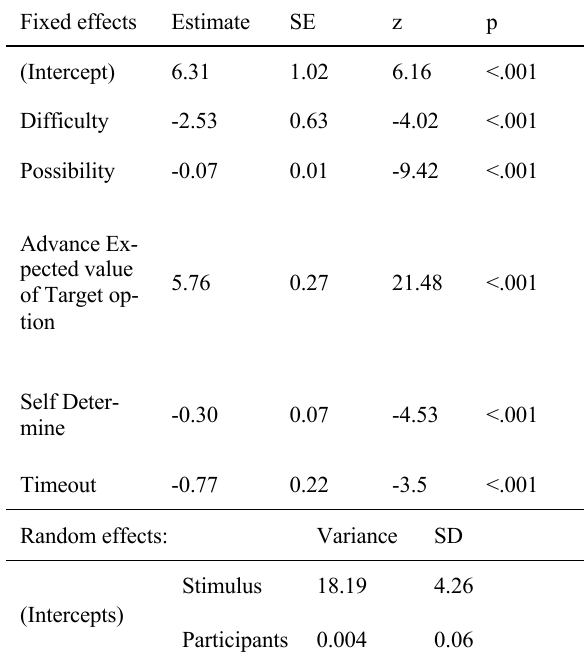
Table 2. Generalized linear mixed model predicting choice the target